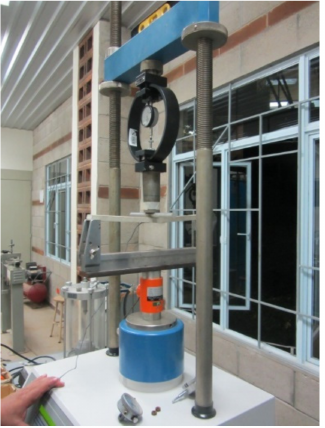
Figure 7. Gradient base floor of the experimental